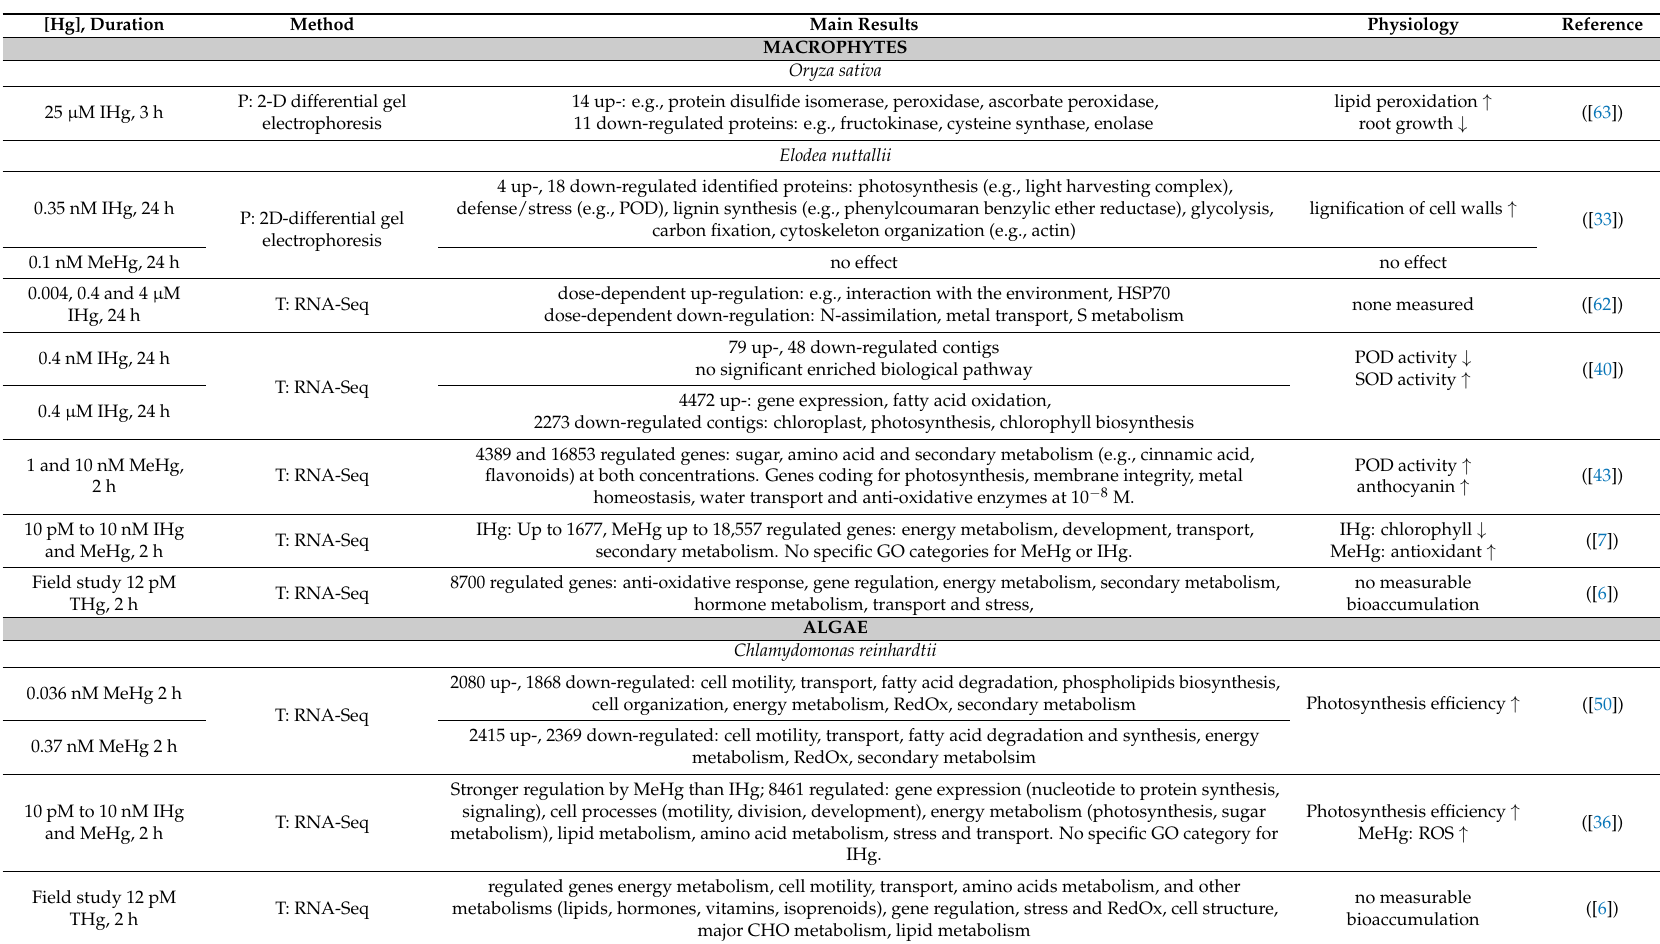
Table 1. Effects of Hg revealed by transcriptomic (T) and proteomic (P) studies in macrophytes and